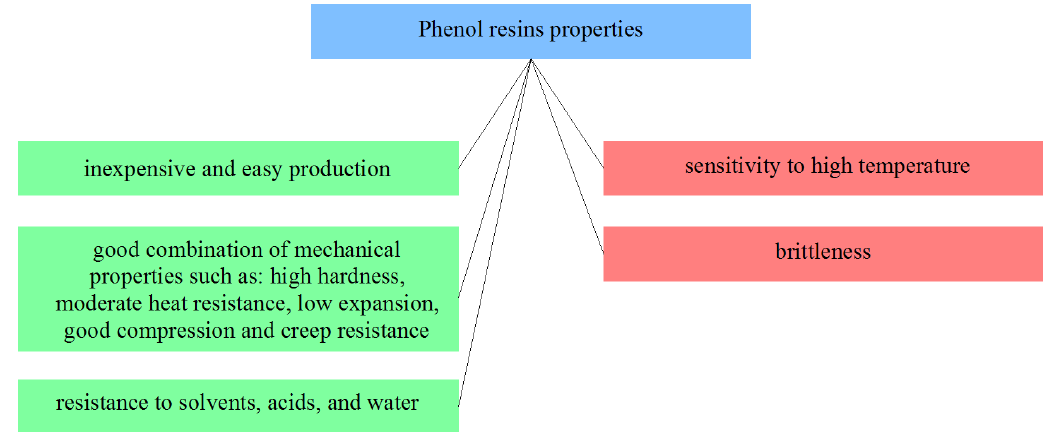
Figure 4: Selected phenol resins properties from the point of view of applicability in friction